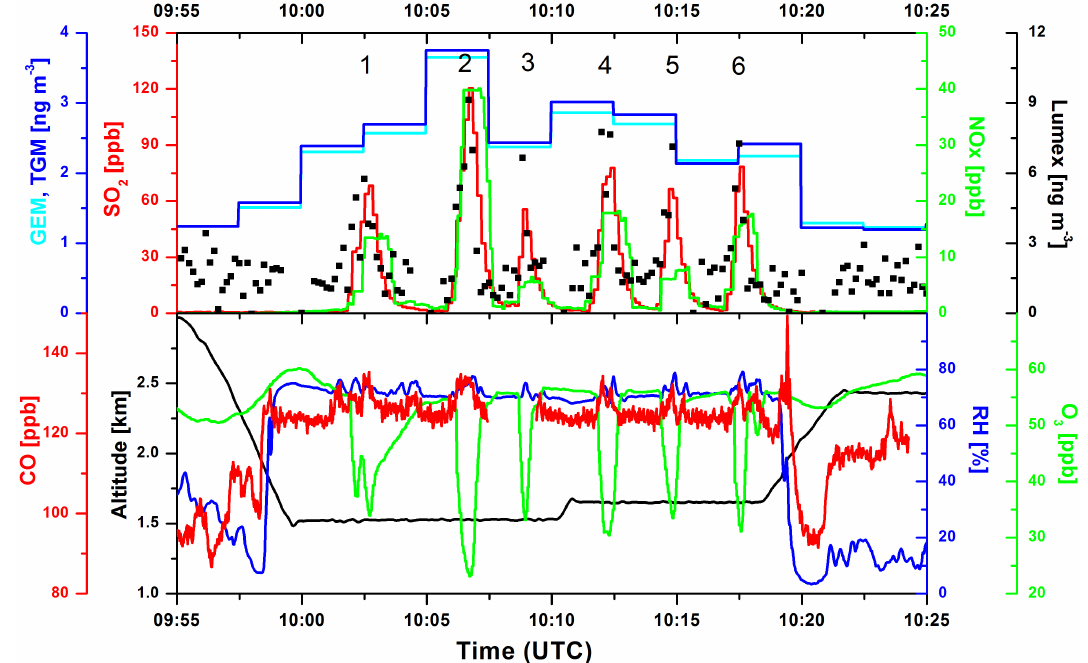
Figure 5. The same as in Fig. 4, but for measurements on 22 August